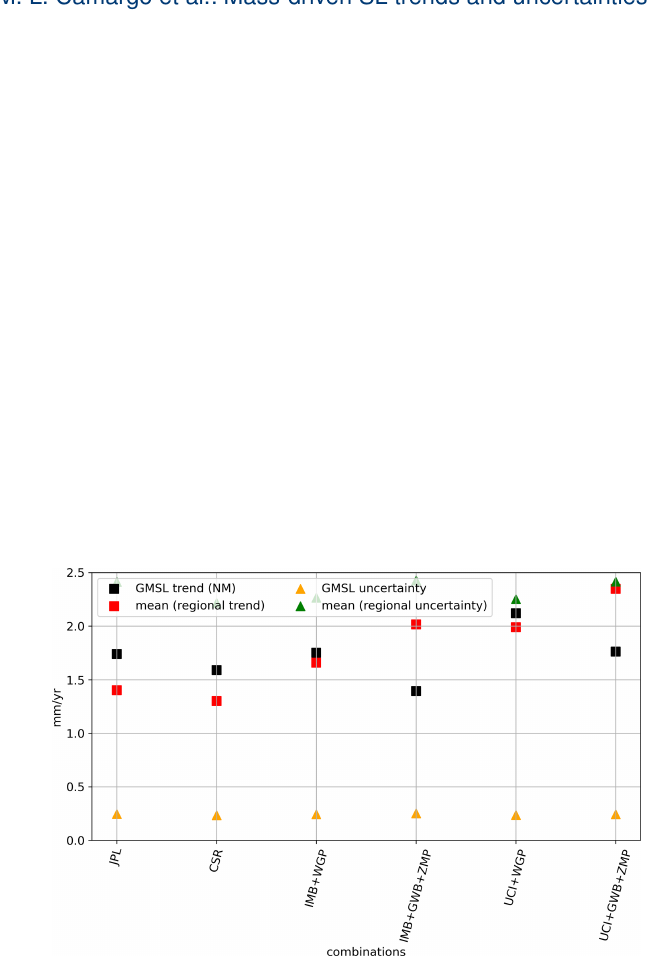
Figure B5. Comparison of global mean sea-level trend (black squares) and uncertainty (yellow triangles) with the spatial aver- age of the regional trend (red circles) and uncertainty (green up- side down triangles) from 2003–2016. The difference between the GMSL trend and spatial average of the regional trend is due to the use of regionally different noise models (following selection of Fig.